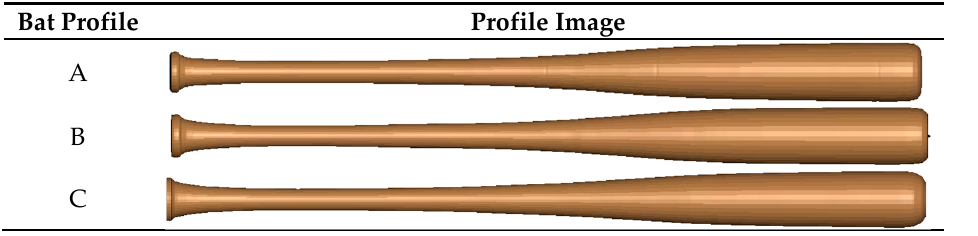
Table 1. Bat Profile Visual Comparison.